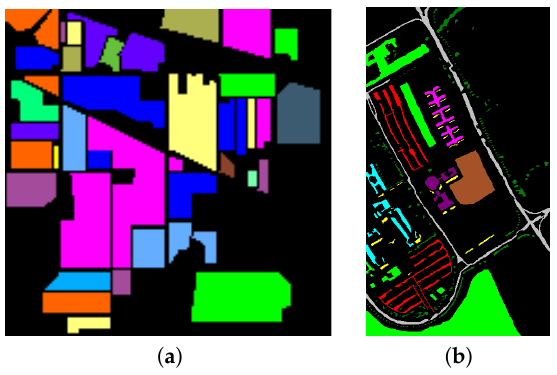
Figure 2. Ground truth image of ( a ) Indian Pines; ( b ) Pavia University. Table 1. Sixteen ground-truth classes in Aviris Indian Pines and the training and test sets for each class.